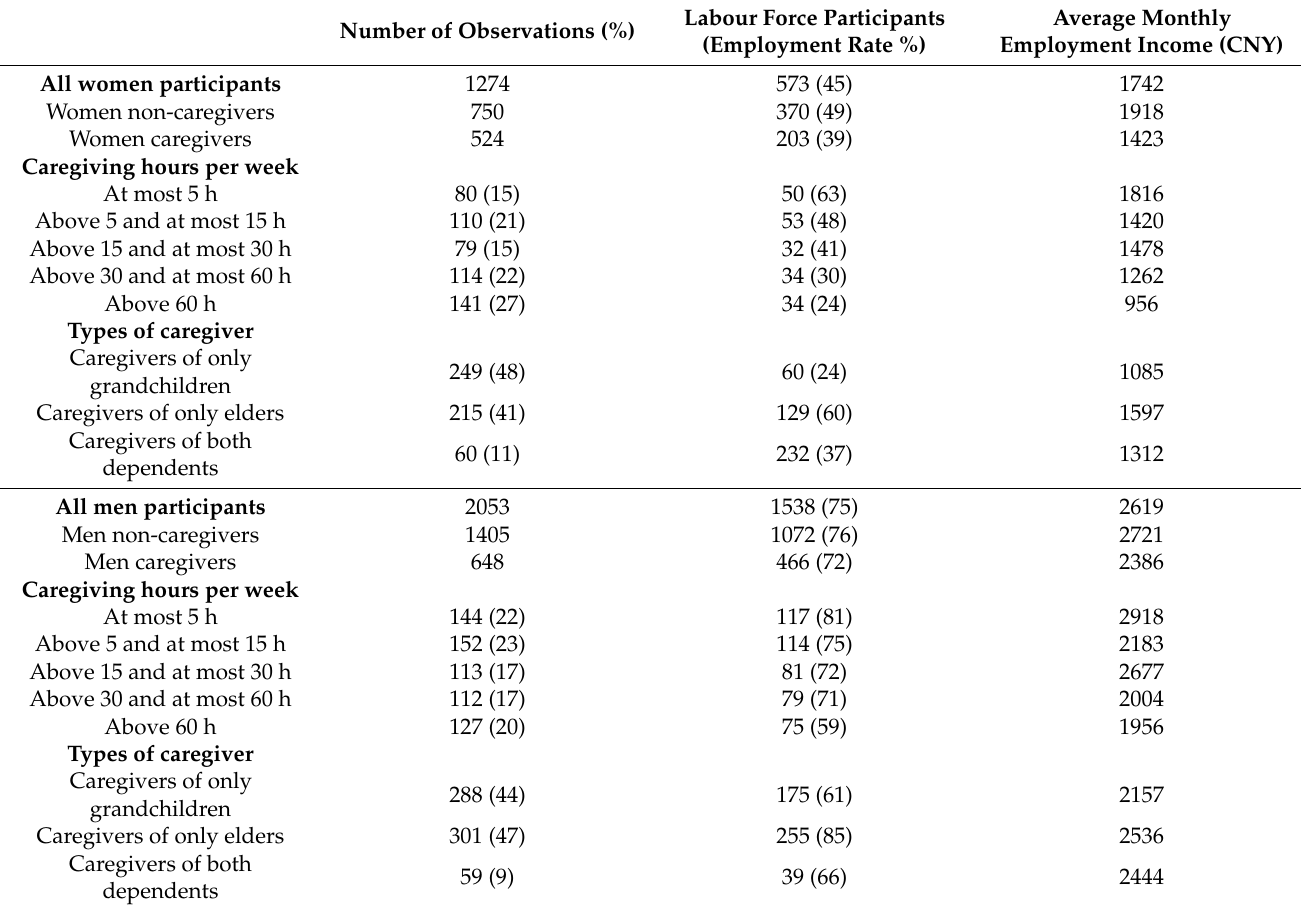
Table 1. Descriptive analysis on caregiving, labour force participation and monthly employment income. Labour Force Participants Average Number of Observations (%) (Employment Rate %)